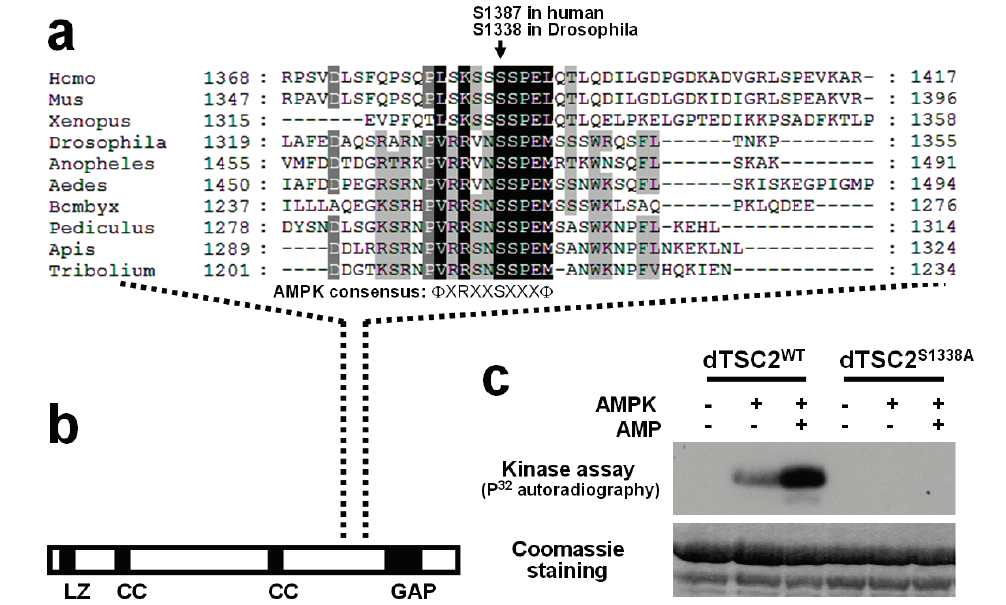
Figure 3. Conservation of AMPK phosphorylation site in Drosophila TSC2. ( a ) Multiple sequence alignment of TSC2-like proteins. A region surrounding the AMPK phosphorylation site (Ser1387 in human TSC2; highlighted in Figure 2 with red box) was magnified here. a.a. residues were shaded as in Figure 2; ( b ) Domain structure of Drosophila TSC2. The AMPK phosphorylation site falls between coiled coil (CC) and GAP domains; ( c ) In vitro kinase assay using purified AMPK protein and recombinant wild-type or Ser1338Ala-mutated Drosophila TSC2 protein corresponding to a.a.